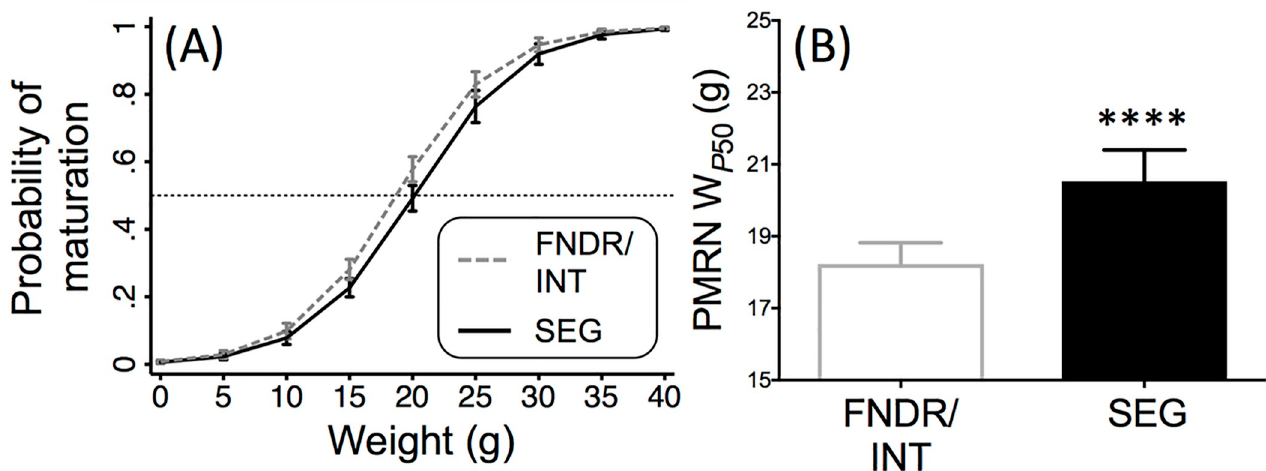
Fig 5. Reaction norm (A) and PMRN W P50 (B) estimates, Part I. (A) Marginally predicted probabilities of age-2 minijack maturation with 95% CI based on the following model: logit[ p ( m )] = β 0 + β 1 w + β 2 g + β 3 y + β 4 gy ( w = weight, g = broodline, y = brood year) for spring Chinook salmon sampled from Clark Flat acclimation site, BYs 2002–2011 (see S3 Table). Dashed horizontal line indicates probability of 50% maturity. (B) Mean weight at 50% maturity (PMRN W P 50 ) estimates, years as replicates{estimated from the model: logit[ p ( m )] = β 0 + β 1 w + β 2 g ; run separately for each brood year (see S4 Table)}. Only males were included in these analyses. ���� P <